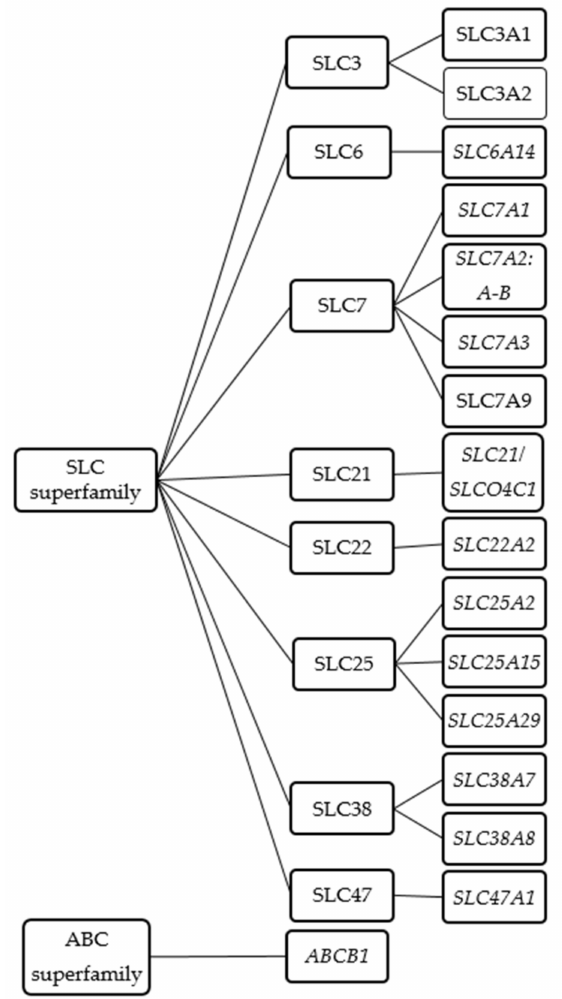
Figure 1. Schematic diagram of known L-arginine and its derivatives